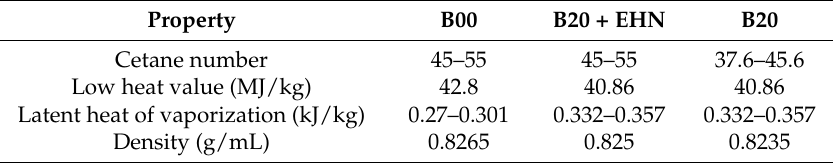
Table 2. Comparison of main physical properties of blended fuels.